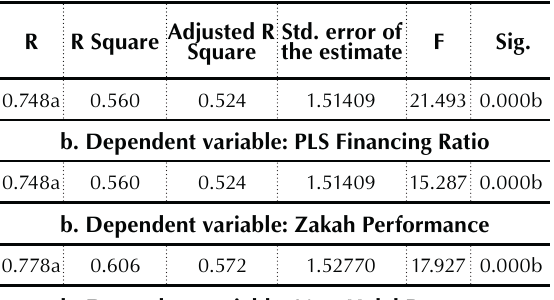
Table 2. Test result model